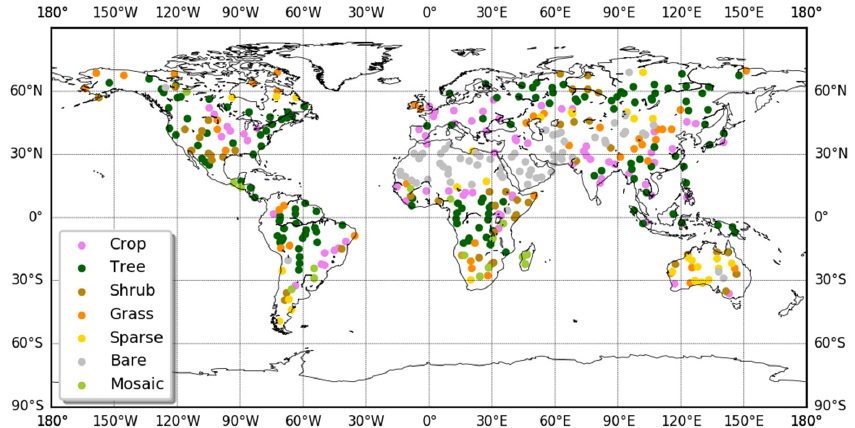
Figure 3. The figure shows the location of BELMANIP-2 sites [34] used for assessing the multi-tem- poral consistency of Proba-V TOC products at global scale and for different surface types and